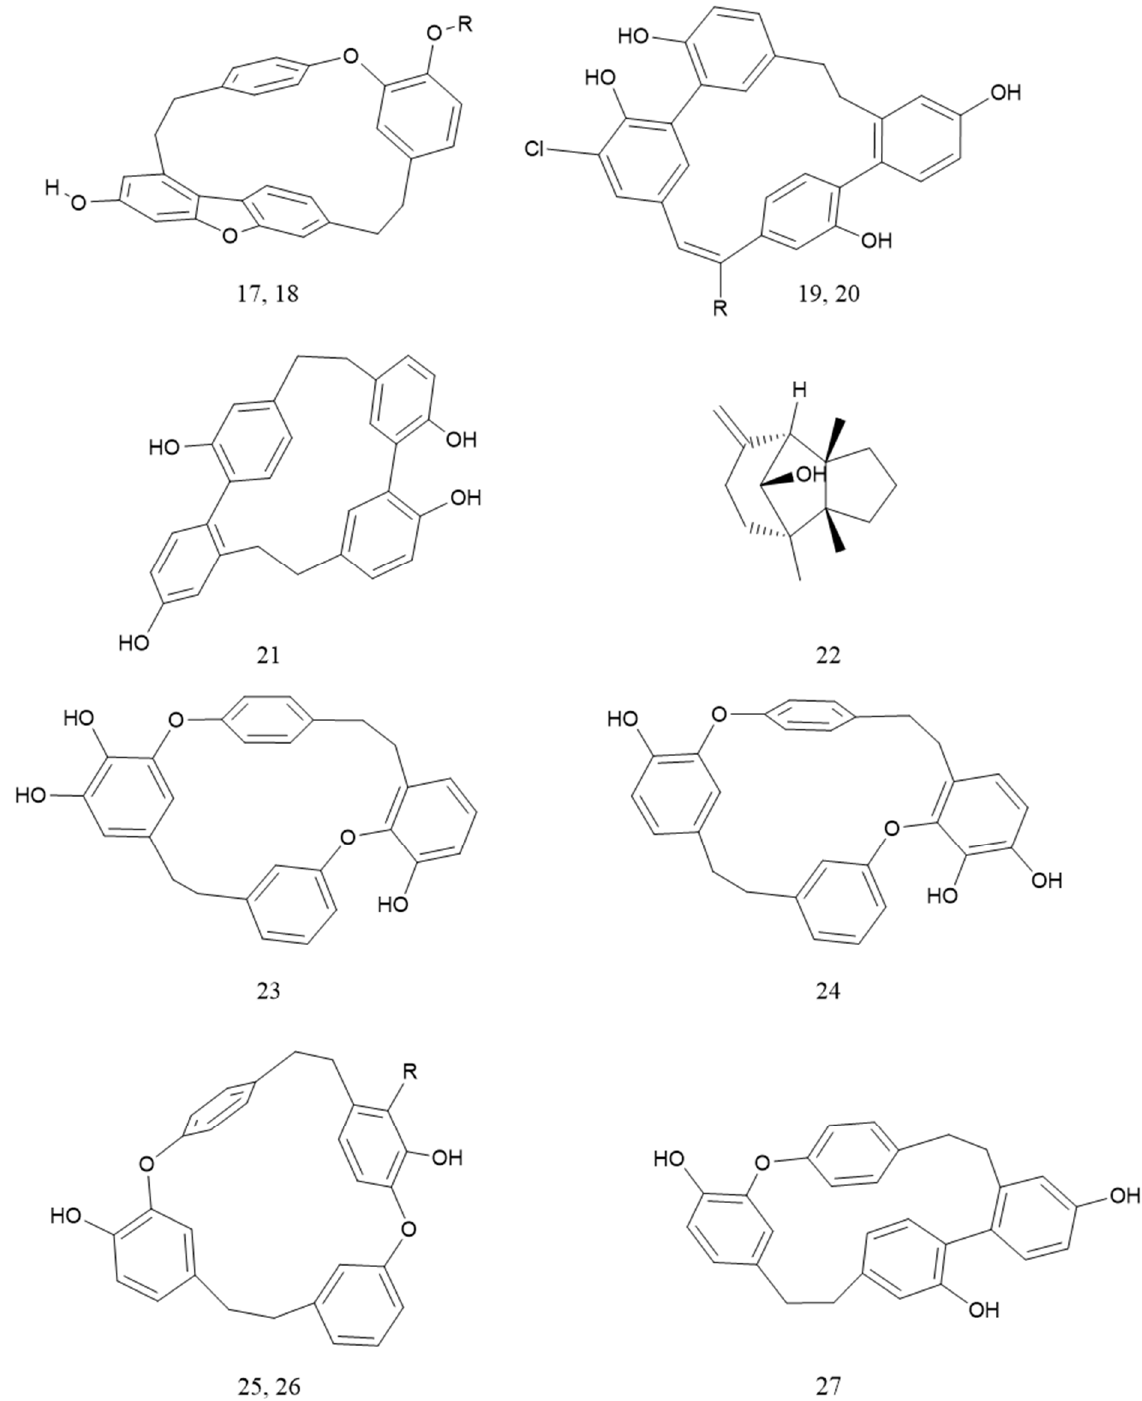
Figure 3. Chemical structures of compounds mentioned in Table 5 ( 17 : asterelin A, R=H; 18 : asterelin B, R=Me; 19 : bazzanin B, R=Cl; 20 : bazzanin S, R=H; 21 : isoplagiochin D; 22: isoriccardin C; 23 : gymnomitrol; 24 : marchantin H; 25 : neomarchantin A, R=H; 26 : neomarchantin B,